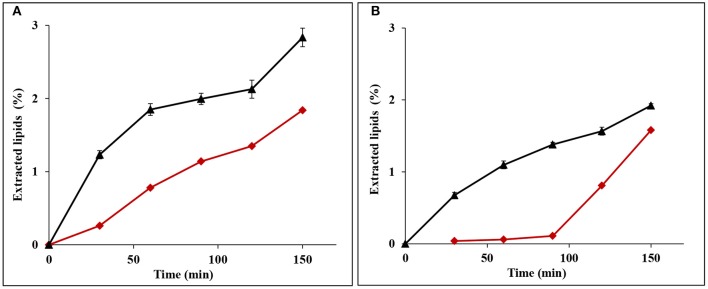
Profile of defatting rate of (A) fine and (B) coarse wheat brans during lipid extraction by SC-CO2. Symbols indicate (▴) wheat brans without de-starching (average ± std deviaton of three experiments) and (♦) wheat brans after de-starching (single experiments). The data is given as % of bran dryweight.